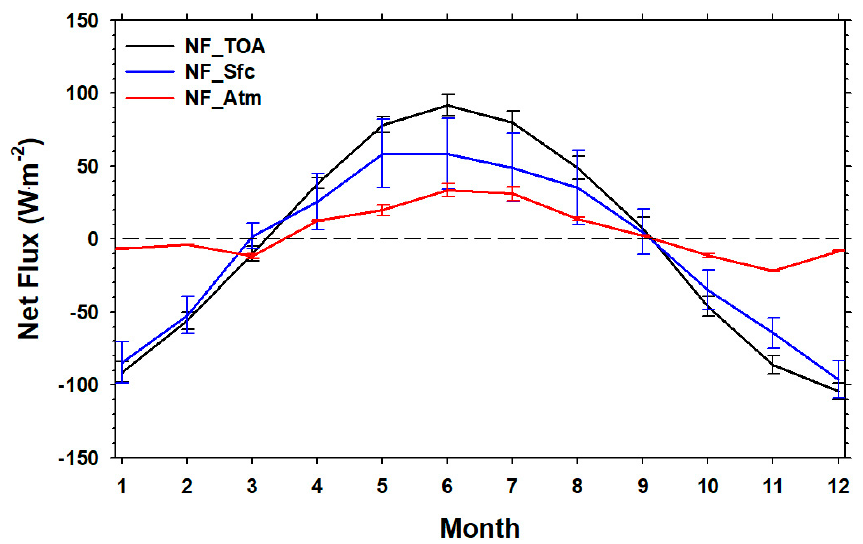
Figure 4. Variation of monthly mean net flux during 2021 (black, blue, and red lines represent the top of atmosphere, surface, and atmosphere, respectively. The vertical bars in this figure represent the standard deviation, but their values are too small. So, they are drawn by magnifying them five times).